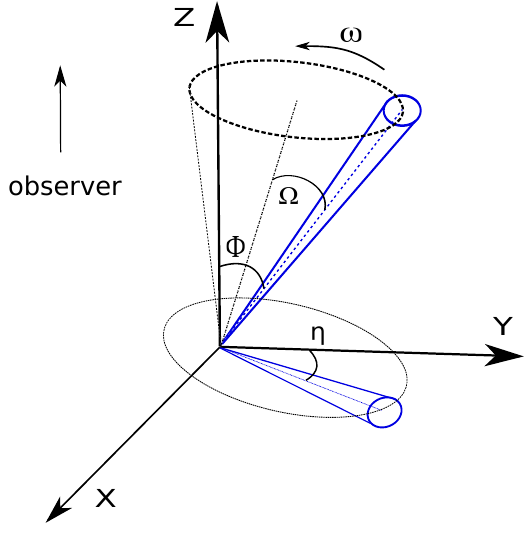
Figure 2. Jet precession geometry. The line of sight is parallel to the z axis. Right ascension and declination correspond to the x and y axes, respectively. The η position angle is measured from north through